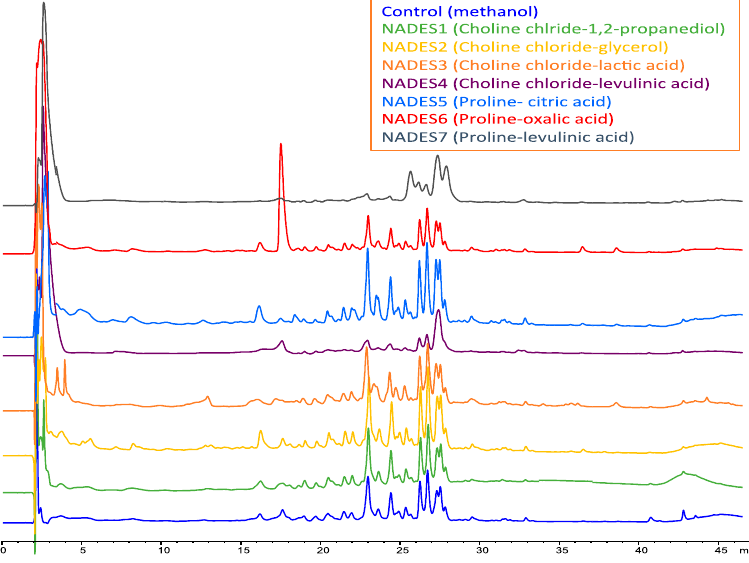
Figure 4. HPLC-PDA chromatograms of the alkaloids from Peumus boldus leaves extracted with different NADES solvents. HPLC separation was performed in reverse phase under gradient. The trace correspond to the signals recorded at 304 nm.